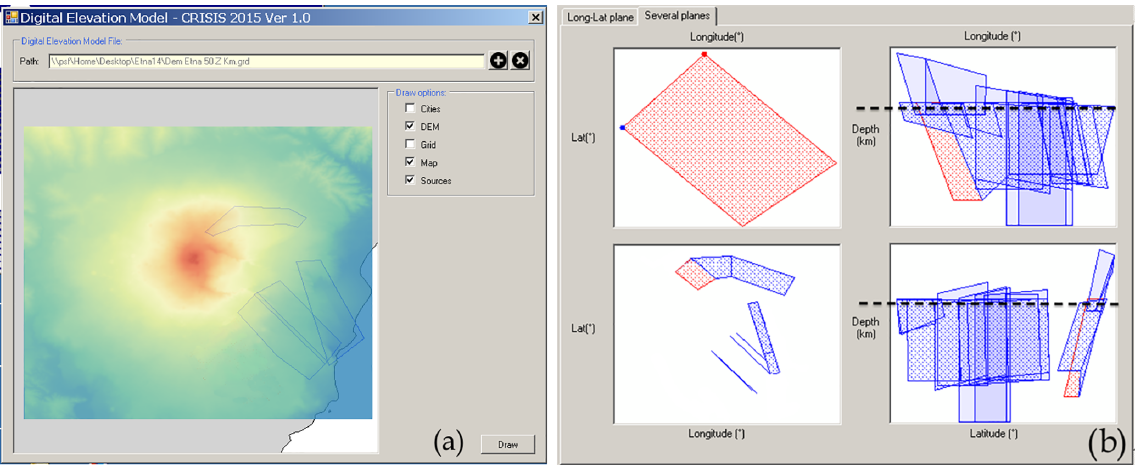
Figure 5. Snapshots of topography and sources in CRISIS. (a) DEM at Mt. Etna with area sources. (b) Preliminary release of fault sources in a 3-D view: the panel in the upper left shows a red fault plane which is projected with other fault sources in lower left; the panels on the right are classical cross sections along longitude (upper) and latitude (lower). Note the vertexes above the sea level, marked by black dashed lines in the cross